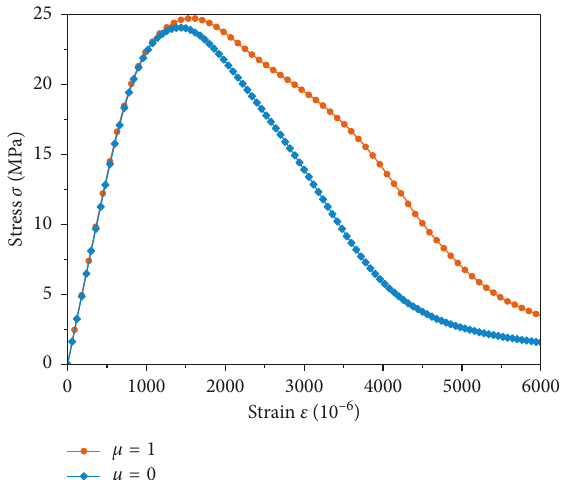
Figure 26: Comparison of the macroscopic stress-strain curve of concrete under different end friction simulate the experiment than the linear elastic damage constitutive model.